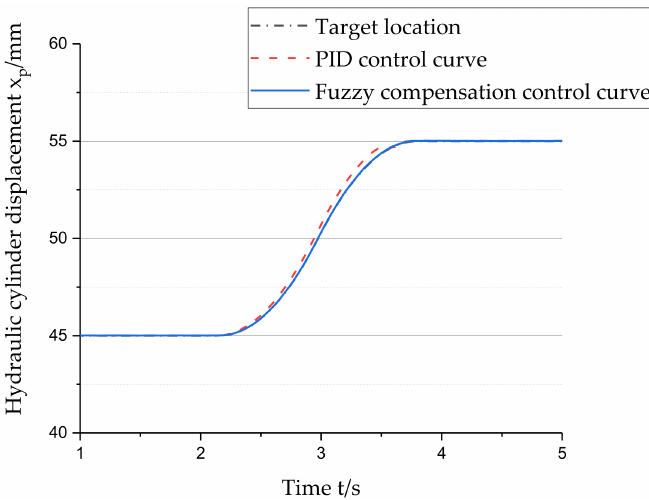
Figure 8. Response curve of the extended position of the hydraulic